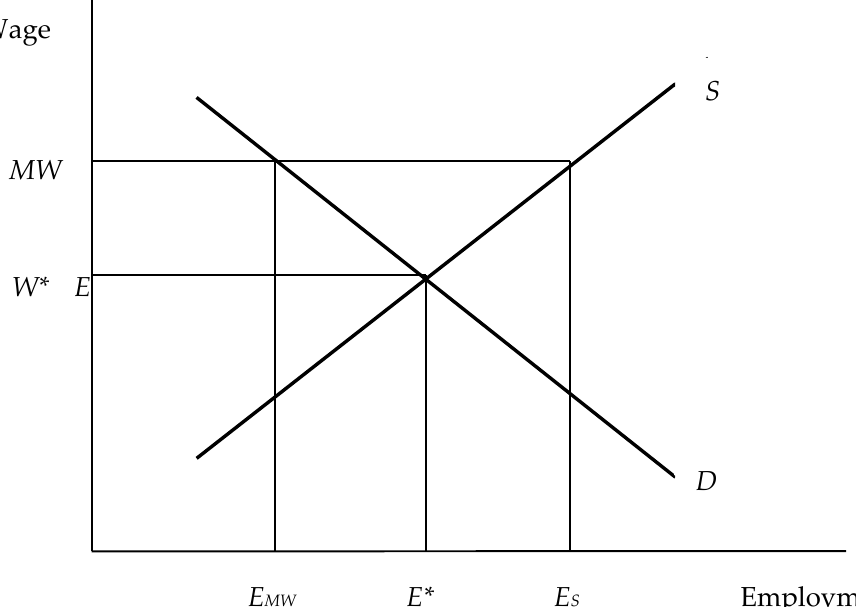
Figure 1. The employment effect of minimum wages in the Neoclassical model. In such a monopsony situation, in the absence of a minimum wage, not only the equilibrium wage but also the number of employees would be lower than what would prevail in conditions of perfect competition (see Figure 2). The monopsonist sets the wage at the point where the marginal cost of labor ( MC E ) equals the marginal revenue of the product ( VMP E ). At this wage ( W MP ), the number of workers employed is E MP , which is less than that in the case of the competitive level E* . Therefore, in a monopsony labor market, there is underemployment. In that sense, if the government imposes a wage floor of W ’, the firm can hire up to E ’ workers, which implies that the imposition of a minimum wage on a monopsonistic market can increase employment.